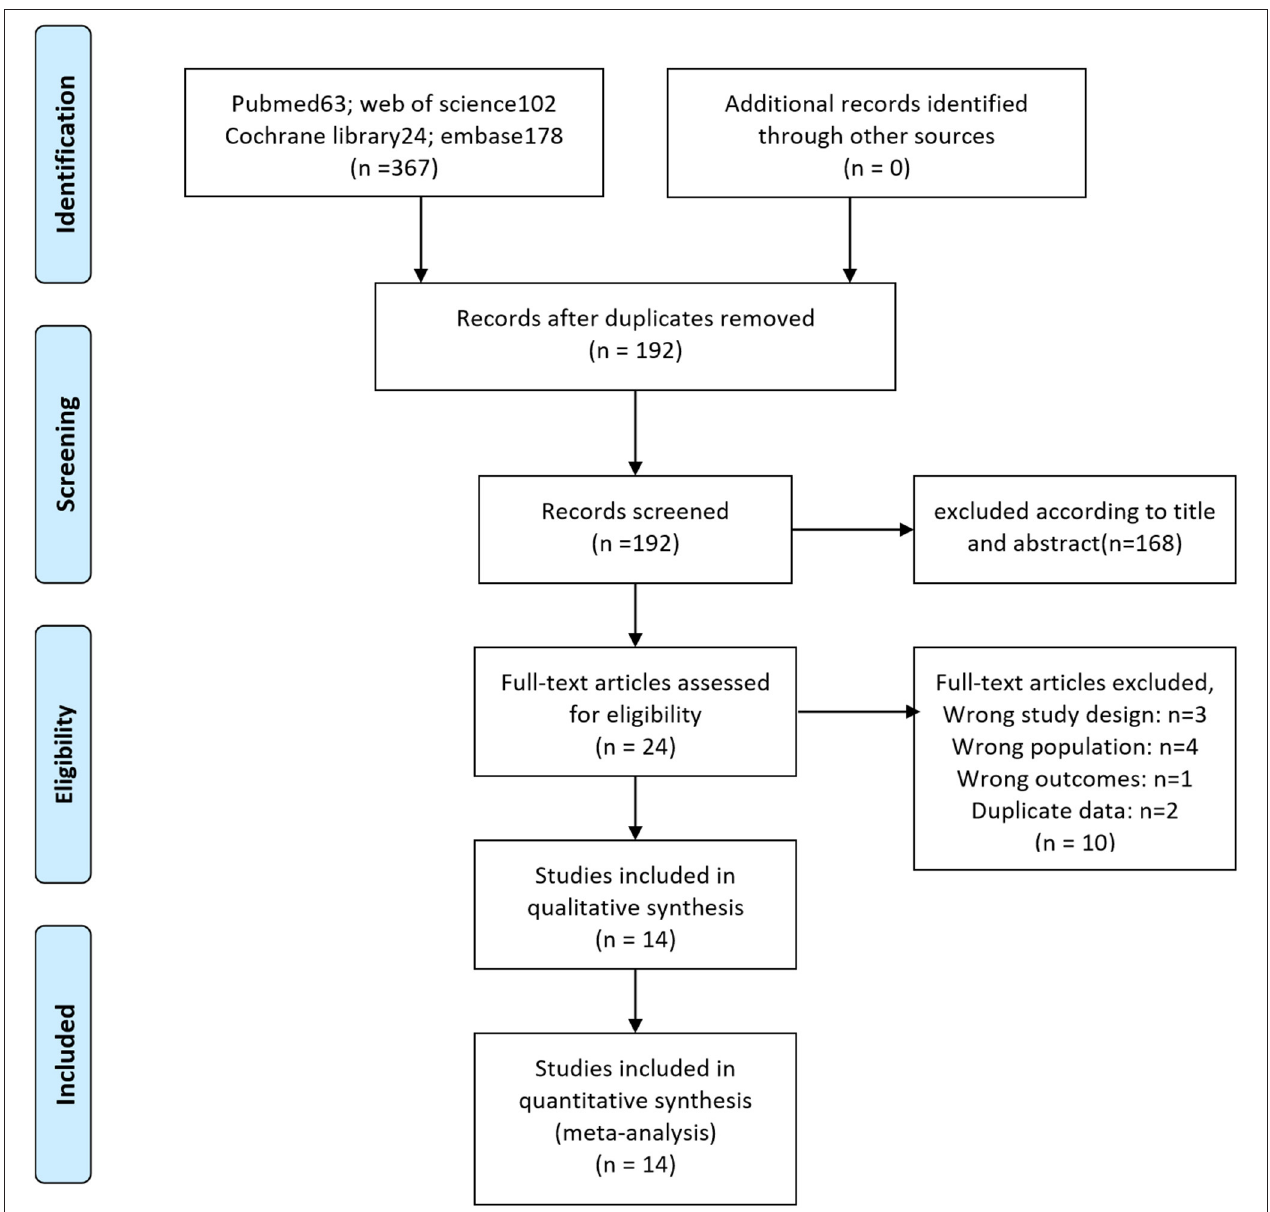
FIGURE 1 | Literature search and